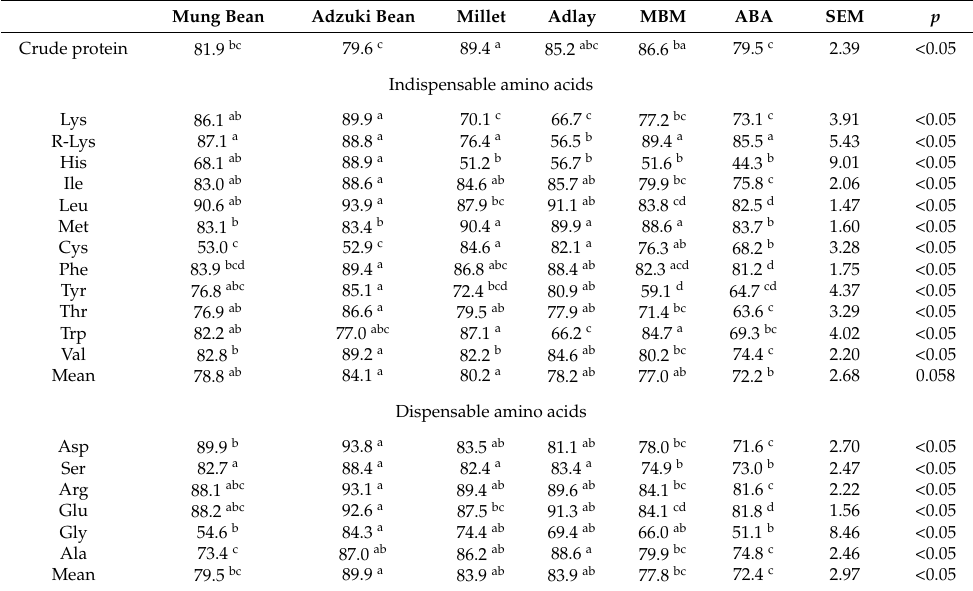
a,b,c,d Mean values in a row with different superscript letters were significantly different ( p < 0.05). True ileal digestibility (TID) values were calculated by correcting the values of apparent ileal digestibility for the basal endogenous losses. Values used for the basal endogenous losses were as follows (g/kg of DMI): Asp: 0.45; Ser: 0.27; Glu: 0.57; Gly: 0.67; His: 0.50; Arg: 0.21; Thr: 0.27; Ala: 0.42; Pro: 3.75; Cys: 0.28; Tyr: 0.12; Val: 0.28; Met: 0.08; reactive Lys: 0.22; Lys: 0.23; Ile: 0.19; Leu: 0.29; Phe: 0.16; Trp: 0.11. MBM: the mixture of mung bean + millet; ABA: the mixture of adzuki bean + adlay; R-lys, reactive lysine; mean TID of indispensable amino acids was calculated using reactive Lys rather than